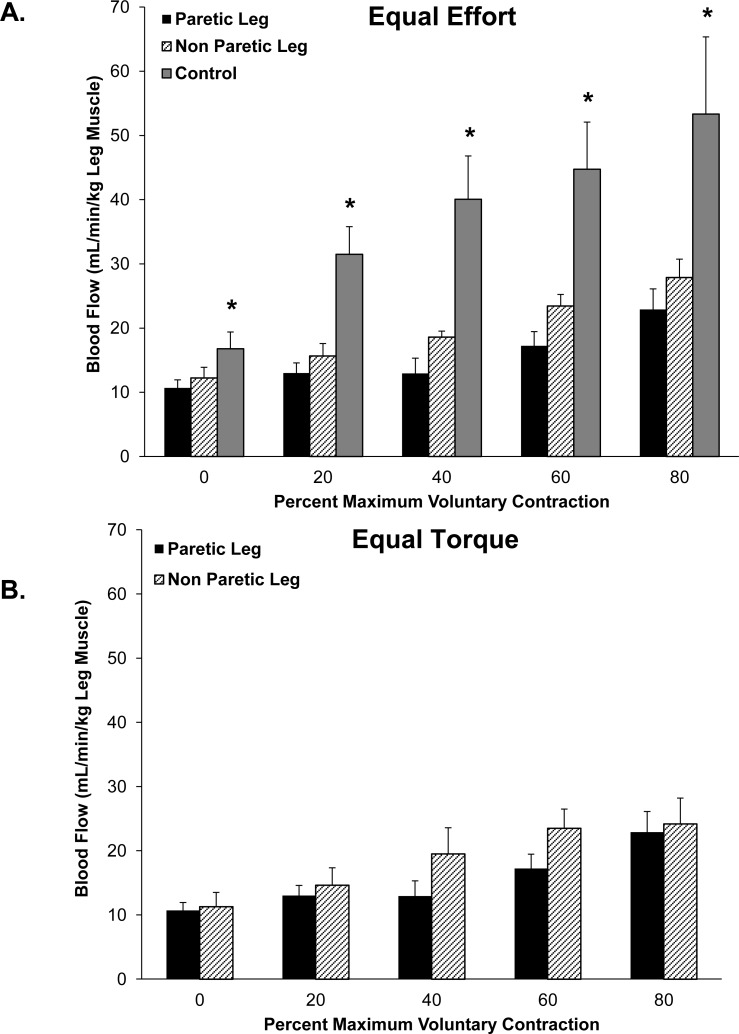
(A) Blood flow through the superficial femoral artery was significantly reduced in the paretic (n = 10) and non-paretic lower limb (n = 10) of stroke subjects in response to 10-second submaximal isometric contractions of the knee extensor muscles compared to age and sex matched control subjects (n = 9). All subjects performed work based on the perceived maximal effort of the test limb (i.e., equal effort). *Significant difference (p<0.05) control vs. paretic and non-paretic lower limb, mixed model repeated measures ANOVA. (B) Blood flow through the superficial femoral artery was similar between the paretic (n = 10) and non-paretic (n = 9) lower limb of stroke subjects when the non-paretic limb achieved target torques equal to the paretic limb (i.e., equal torque). Blood flow data could not be quantified in the non-paretic limb of one subject following the equal torque test session. n, number of subjects.